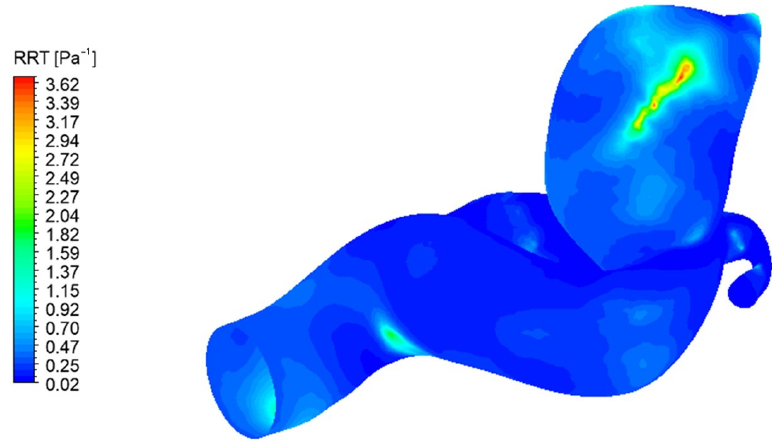
Figure 13. RRT distribution in A-1 model, for the normal/normotensive pressure